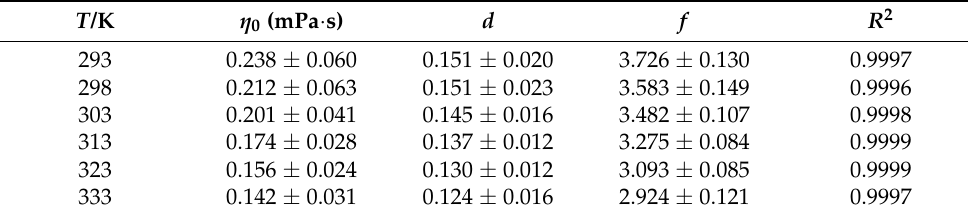
Figure 5. Variation in dynamic viscosities of the investigated mixtures with varying mole ratios of the constituents at different temperatures ( T = 293 to 333 K) and at pressure p = 0.1 MPa. The solid line represents fit to the equation η /(mPa · s) = η 0 /(mPa · s) + d · e f ( x PFD ) . Parameters η 0 , d , and f , along with R 2 , are provided in Table 6. Table 6. Result of the regression analysis of dynamic viscosity ( η /mPa · s) versus mole fraction of PFD ( x PFD ) data according to equation: η /(mPa · s) = η 0 /(mPa · s) + d · e f ( x PFD ) for the investigated mixtures over the temperature range 293 K to 333 K. a T